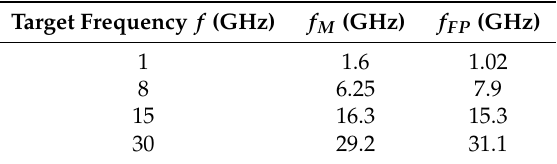
Figure 7. Pulses and fringes generated using Michelson interferometers with different OPD, reported in Table 1: ( a ) 1 GHz, ( b ) 8 GHz, ( c ) 15 GHz, and ( d ) 30 GHz. Table 3. Measured frequencies f M and f FP obtained using Michelson and Fabry–Perot interferometers with OPDs reported in Table